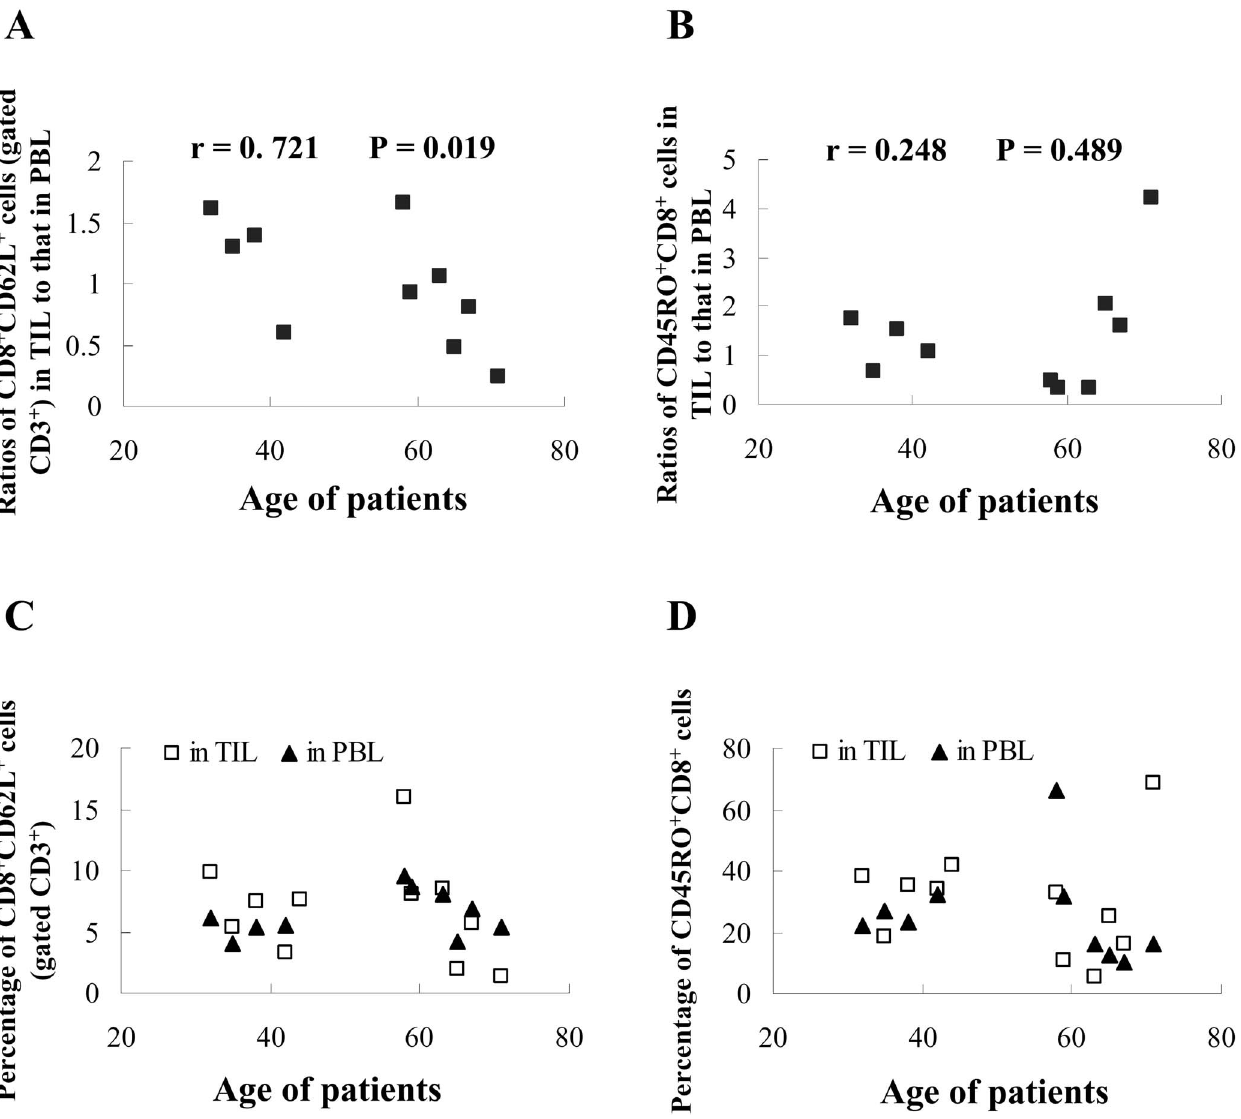
Figure 5. Changed T cell subsets. The freshly isolated TIL or peripheral blood was stained with directly conjugated mouse mAbs against human antigens, CD45RO-ECD/CD8-FITC, or CD3-PC5/CD8-FITC/CD62L-PE. The ratios of percentage of CD8 + CD62L + subset (gated CD3 + cells) in TIL to that in coupled PBL ( A ) and percentage of CD45RO + CD8 + subset in TIL to that in coupled PBL ( B ) were matched with the ages of patients. The coupled percentages of CD8 + CD62L + subset (gated CD3 + cells) in TIL and PBL ( C ) and CD45RO + CD8 + subset in TIL and PBL ( D ) were matched with the ages of patients. The data for PBL of patient PC2 (age 44) is not available.